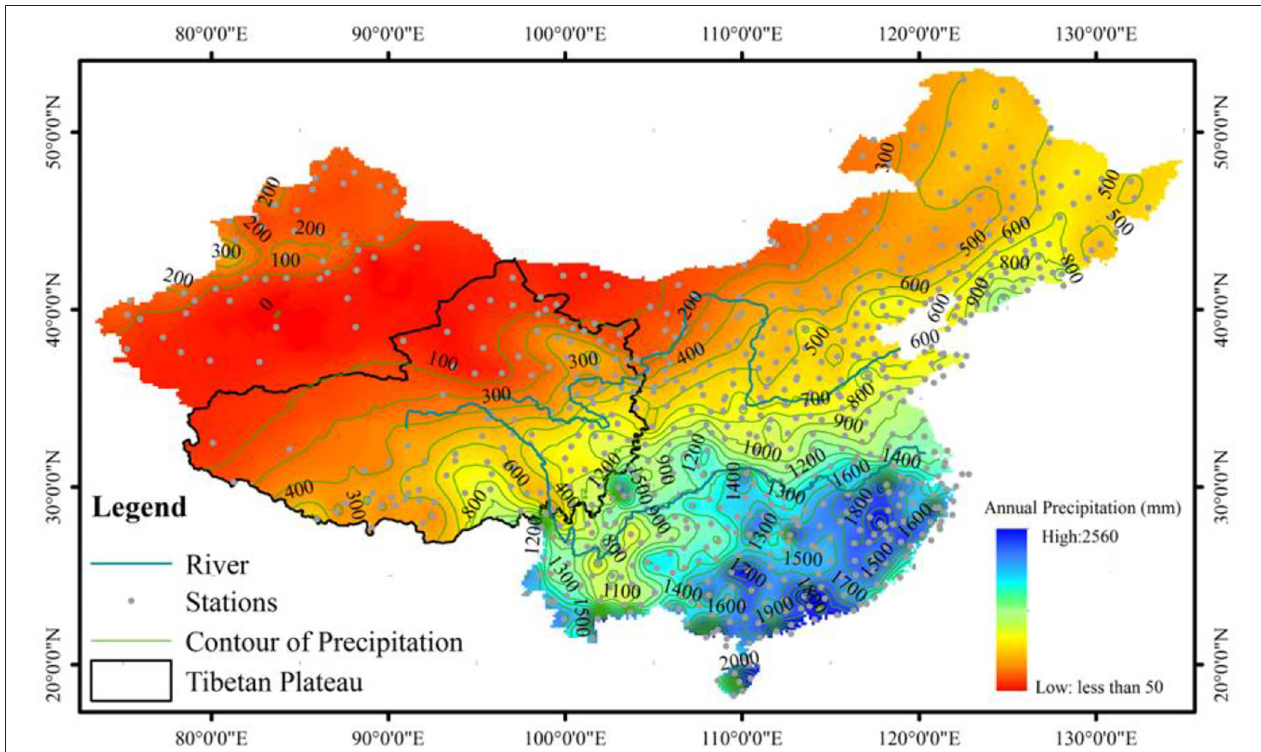
FIGURE 2 | Map covers only the study area where weather stations are located with contours of average annual precipitation in mm.